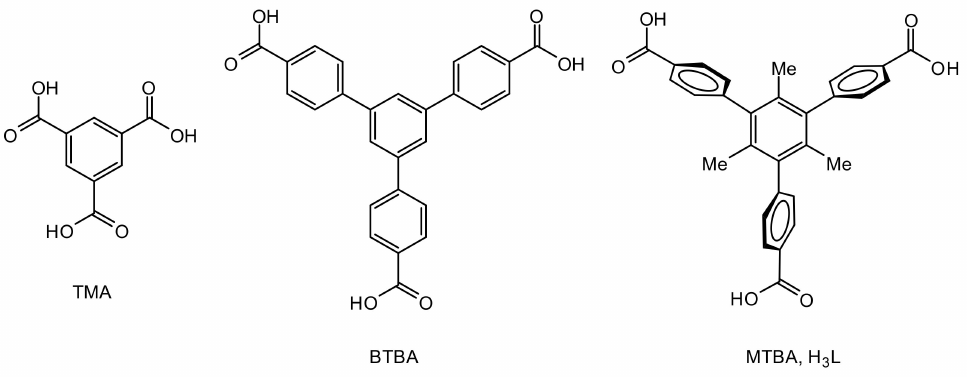
Figure 1. Tritopic linkers used in the construction of metal-organic frameworks